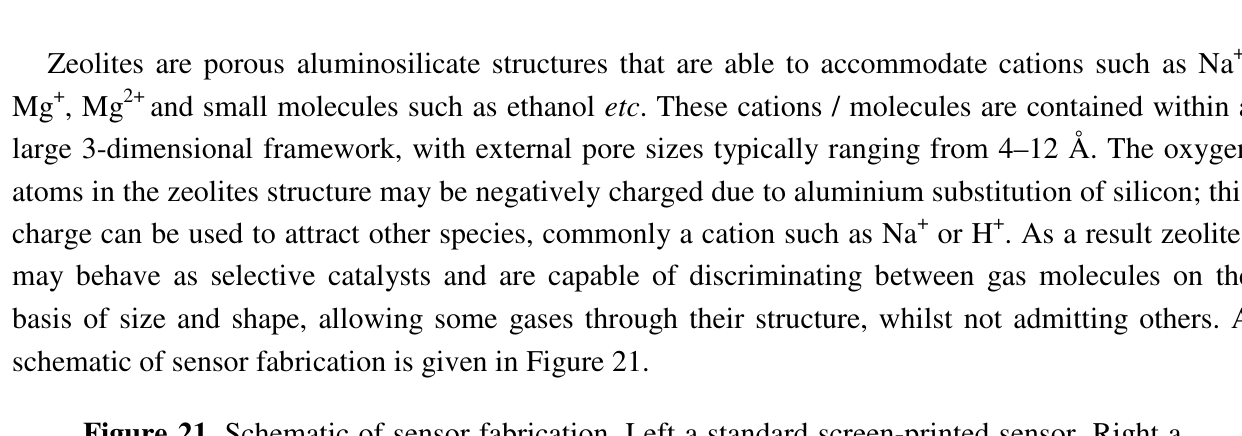
Figure 21. Schematic of sensor fabrication, Left a standard screen-printed sensor, Right a sensor modified with a zeolites over-layer.